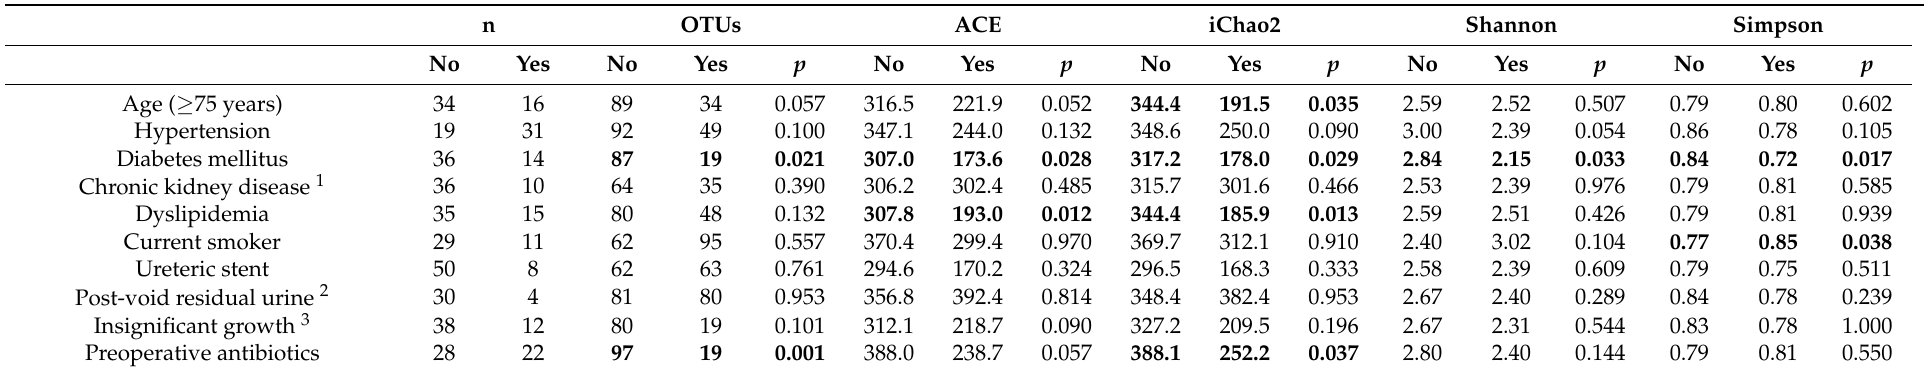
Table 1. Median alpha diversity indices for the clinical conditions reported in this study. Columns denote the patient’s affiliation to individual clinical conditions (rows) and p -values. Values in boldface are statistically significant. OTUs—number of OTUs representing 95% of the community. Note the consistent differences across all alpha diversity measures for diabetes. See the Discussion section for more